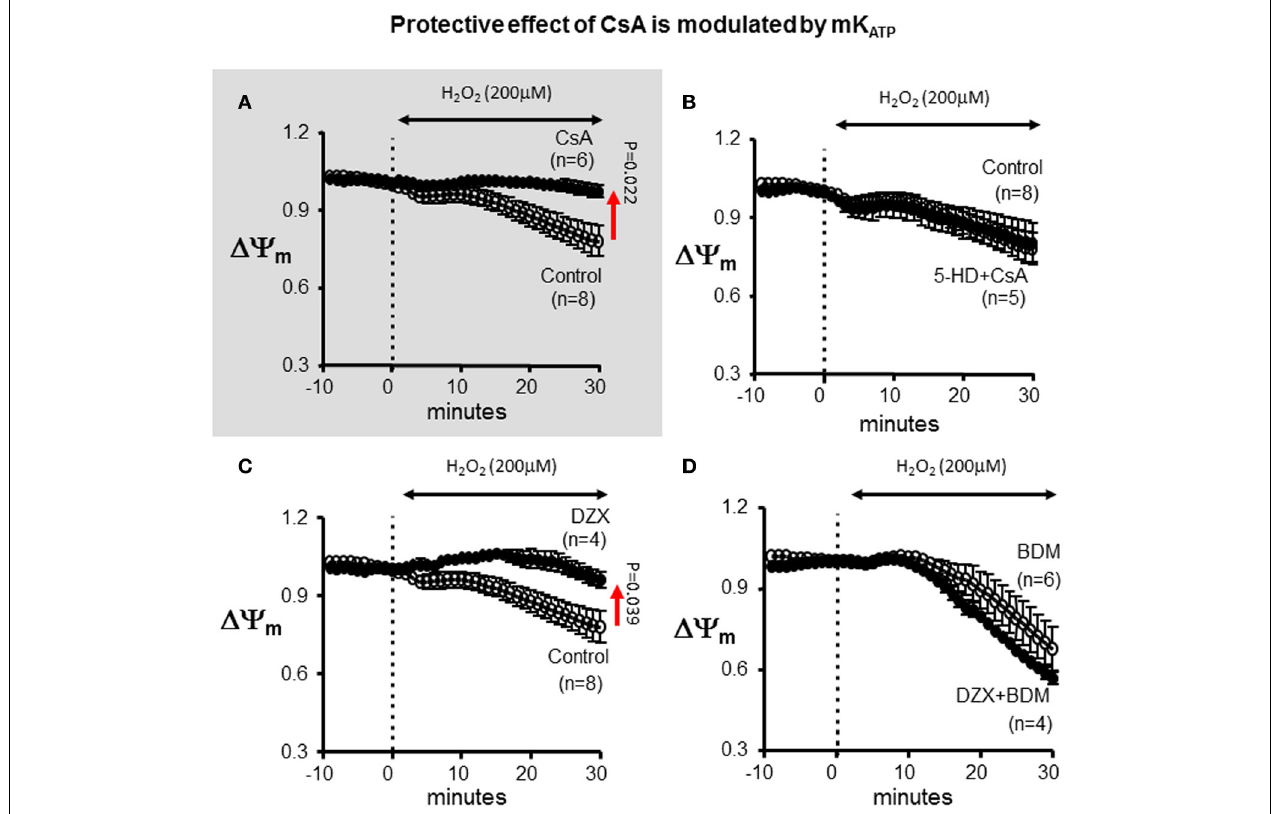
FIGURE 5 | Protective effect of CsA is modulated by mK ATP . (A) For reference, (cid:2)(cid:3) m response presented in Figure 1 indicating protection by CsA against OS-induced (cid:2)(cid:3) m depolarization. (B) Treatment with the mK ATP antagonist abrogates the protective